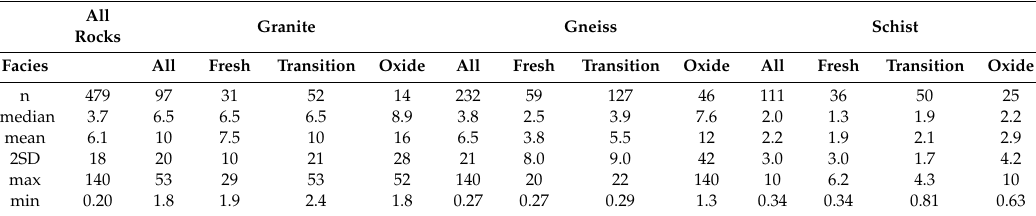
Table 1. Uranium abundance at the Co ff ee deposit by rock type and weathering facies (all units µ g / g). All Granite Gneiss Schist Rocks Facies All Fresh Transition Oxide